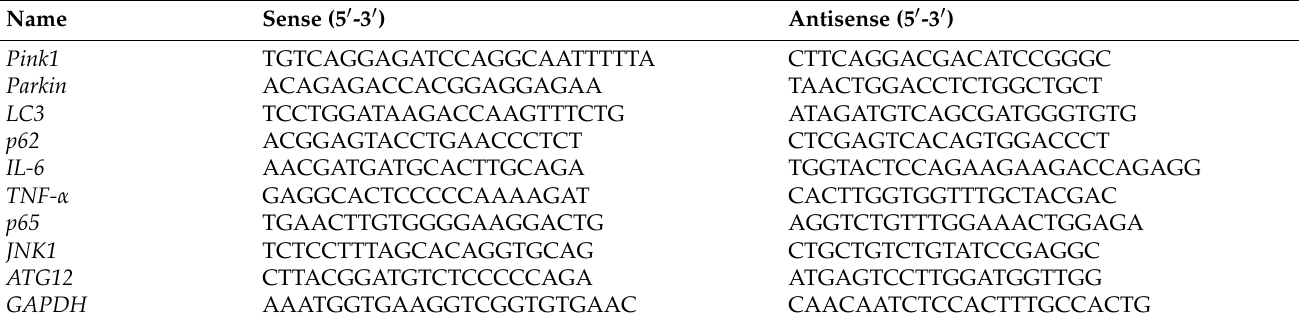
Table 1. The primer sequence of